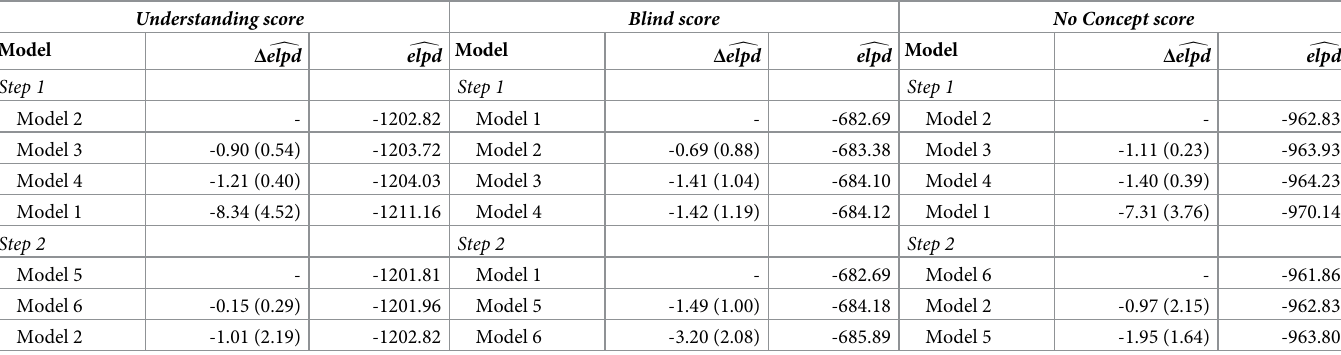
Table 3. Model comparison for the three core variables: Understanding score, blind score and no concept score. Understanding score Blind